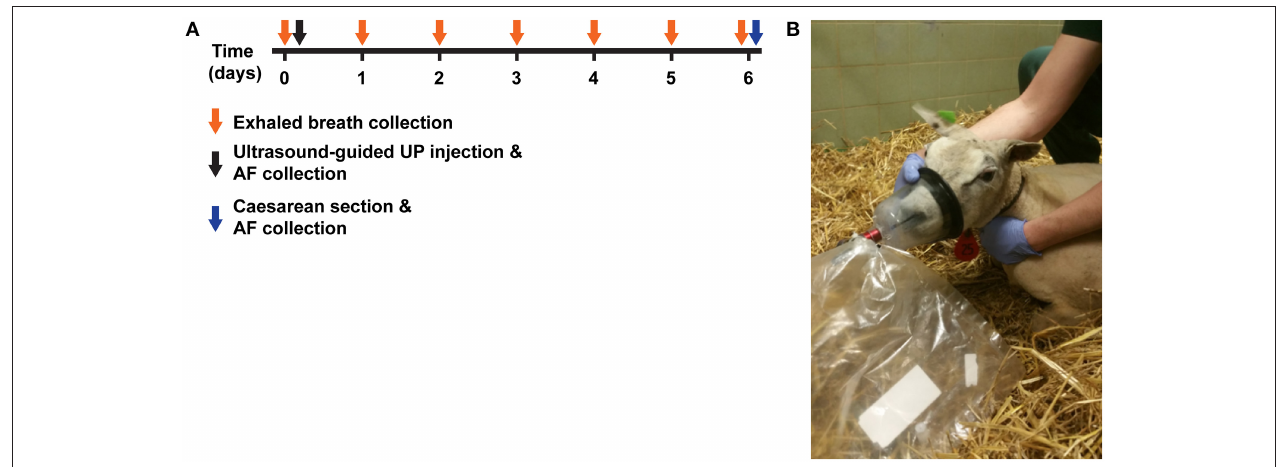
FIGURE 1 | Experimental design. (A) Time-mated Texel ewes were given an intra-amniotic injection of UP (5.0*10 5 CCU). Prior to ( t = 0) and daily for 6 days after injection, exhaled breath was collected by inflation of 5L Tedlar back through a mouth-nose mask connected to a two-way non-rebreathing valve. Six days ( t = 6) after intra-amniotic UP-exposure, fetus were delivered by Cesarean section and used for experimented reported elsewhere ( 27). Group 1 ( n = 4) was sampled first, followed by group 2 at a later time point. (B) Illustrative picture of exhaled breath collection in UP-exposed sheep. VOC, volatile organic compound; UP, U. Parvum .